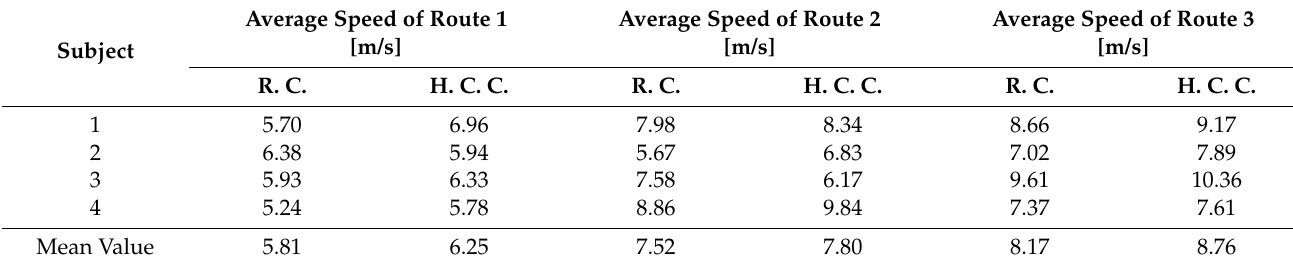
Table 1. Average driving speed of each subject in remote control and human–machine cooperative control mode in three routes.